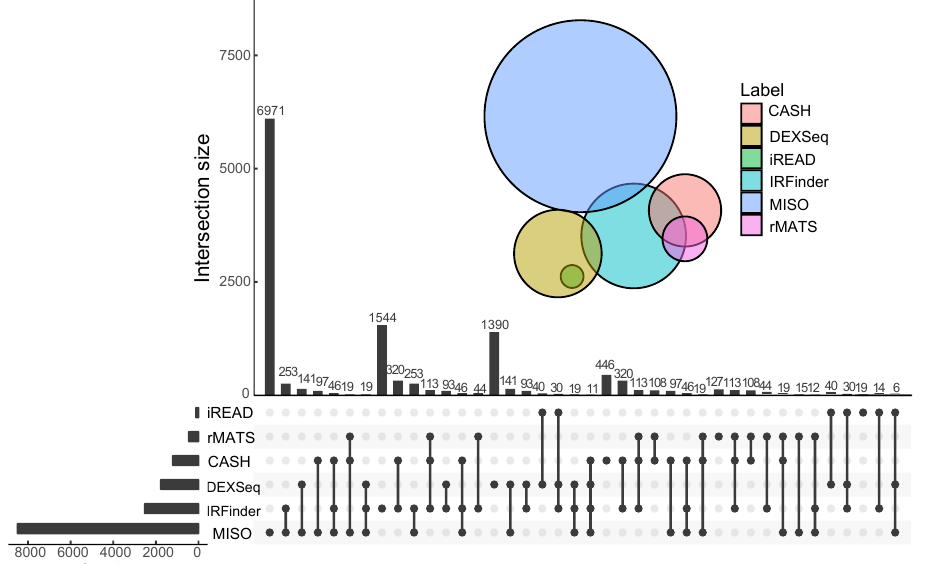
Fig. A3 A combination diagram of Venn and UpSet shows the IR intersection of six methods on human SRR5305480. Technology Program (No.